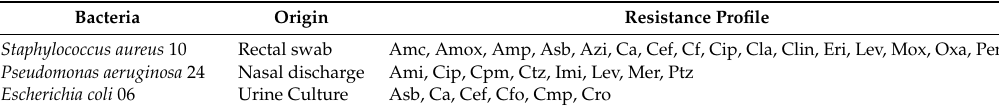
Table 2. Resistant profile of the